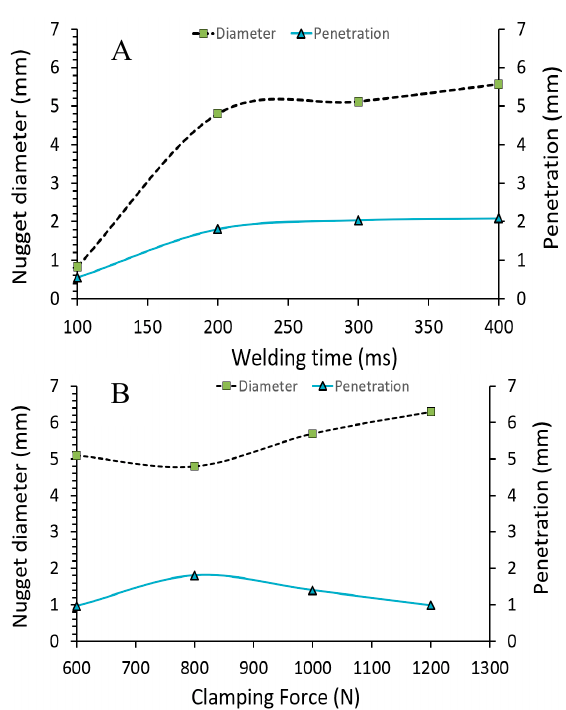
Figure 2. Relationship between resistance spot welding parameter: ( A ) Welding time, nugget diameter, and penetration; ( B ) Clamping force, nugget diameter, and penetration.